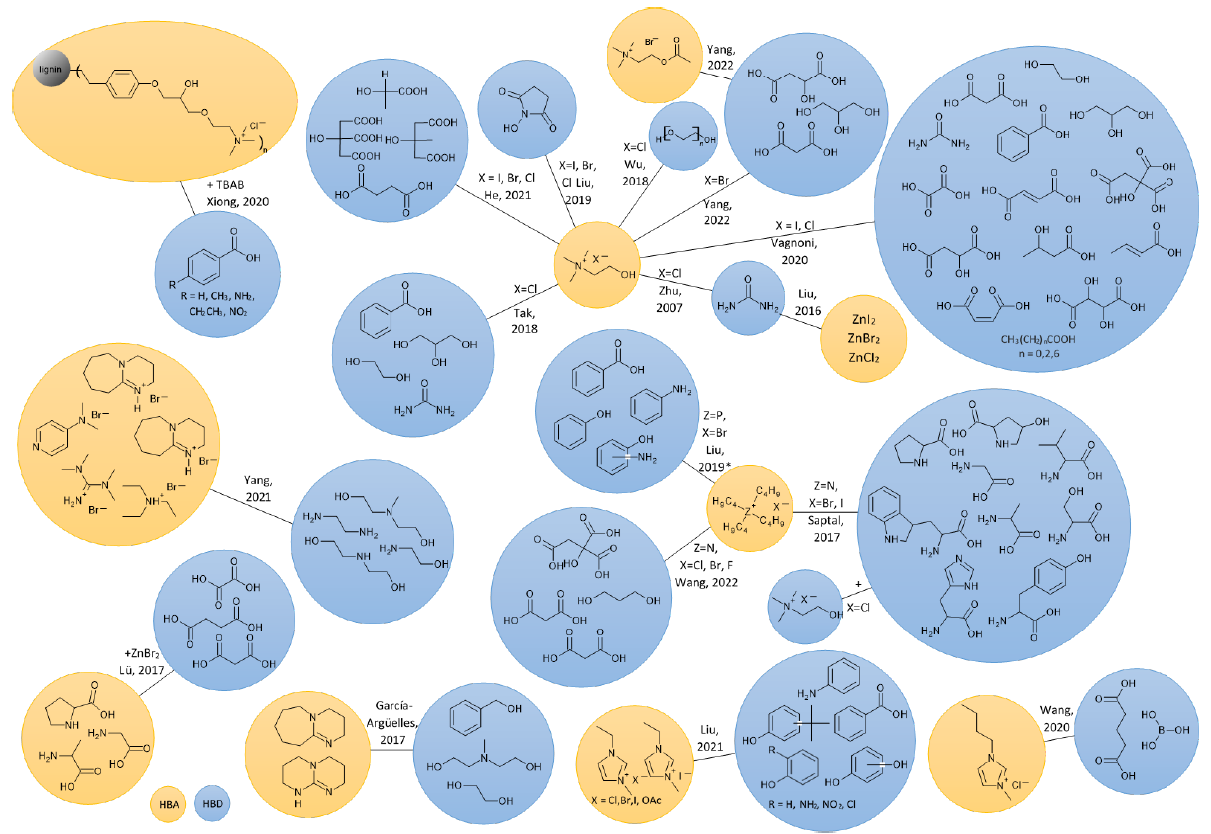
Figure 9. Various DESs used in the synthesis of cyclic carbonates from CO 2 and epoxides. Zhu, 2007 [50]; Liu, 2016 [46]; García-Argüelles, 2017 [53]; Lü, 2017 [33]; Saptal, 2017 [52]; Tak, 2018 [58]; Wu, 2018 [28]; Liu, 2019 [43]; Liu, 2019* [40]; Wang, 2020 [32]; Vagnoni, 2020 [36]; Xiong, 2020 [51]; He, 2021 [24]; Liu, 2021 [49]; Yang, 2021 [23]; Wang, 2022 [62]; Yang, 2022 [22].